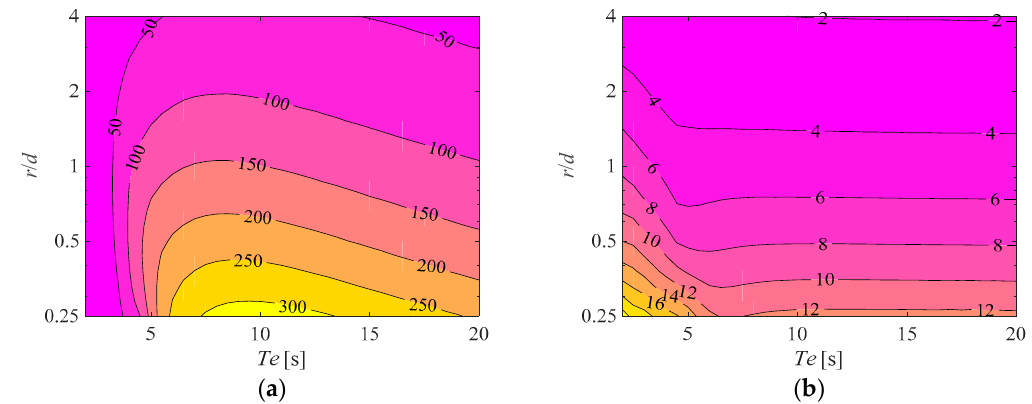
Figure 10. The maximum absorbed power P max and the corresponding optimal significant wave height H s ,opt as a function of the energy period T e and radius-to-draft ratio r / d : ( a ) Maximum absorbed power in kW; ( b ) the corresponding optimal significant wave height in m.